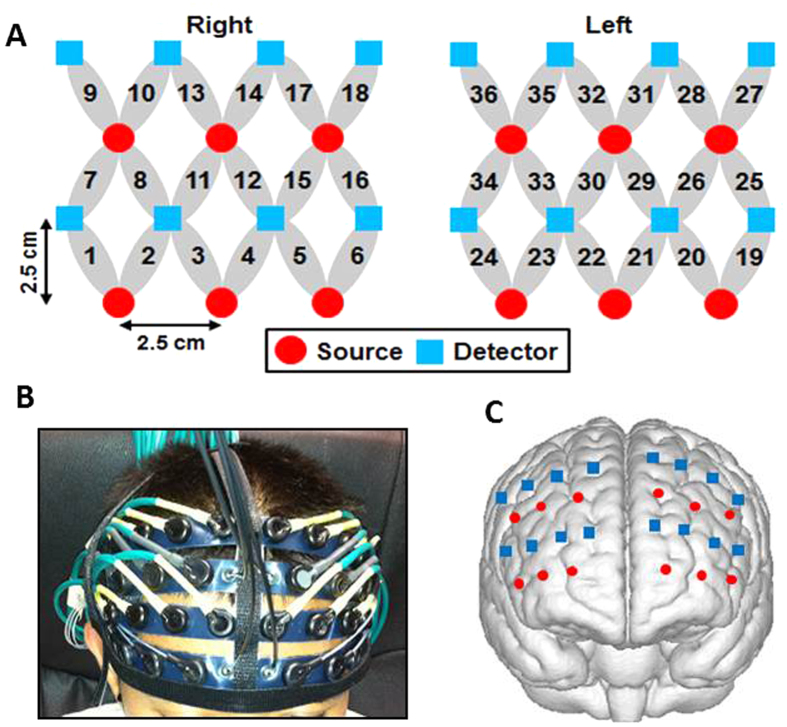
Configuration and cortical position of the multi-channel fNIRS probe array.(A) Configuration of the fNIRS probe. Red circles represent light sources, blue squares represent detectors, and gray ellipses represent the nearest source-detector pairs (as channels) to measure the brain activities. (B) Placement of the fNIRS probe on a participant’s forehead. (C) Co-registration of the sources and detectors on a standard brain atlas template. The probe partially covers the frontopolar, dorsolateral, and ventrolateral prefrontal regions on both hemispheres. The anatomical position of each channel on the brain atlas is detailed in Table 3.